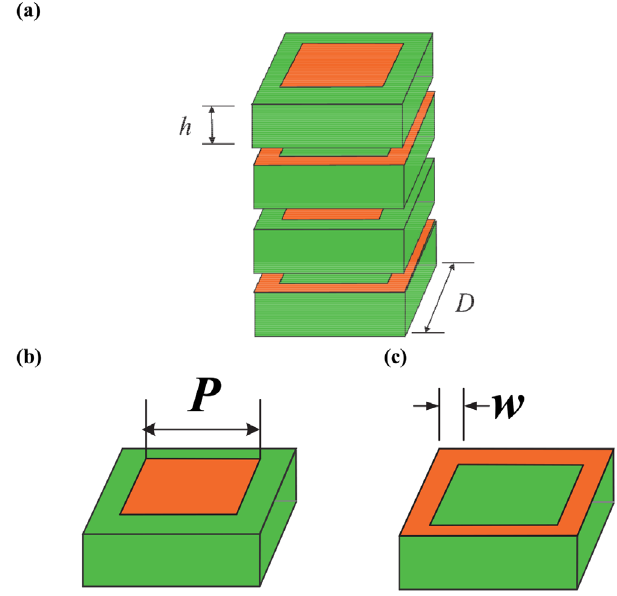
Fig. 2. Geometry structure of MNMS unit cell, (a) multilayer model, (b) square metal patch, and (c) square metal ring.